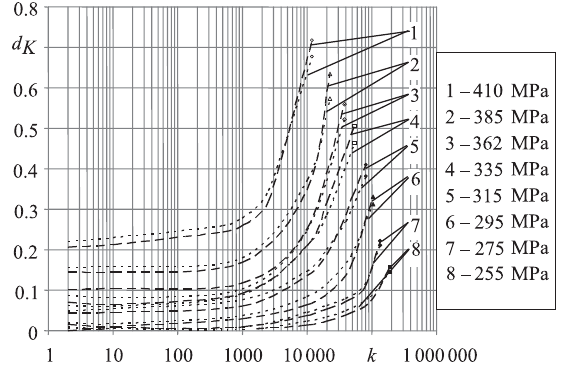
Fig. 10. Quasi-static damage variation in pulsating loading: ................ calculated by the real width of the hysteresis loop, _ _ _ _ calculated by the mean width of the hysteresis loop